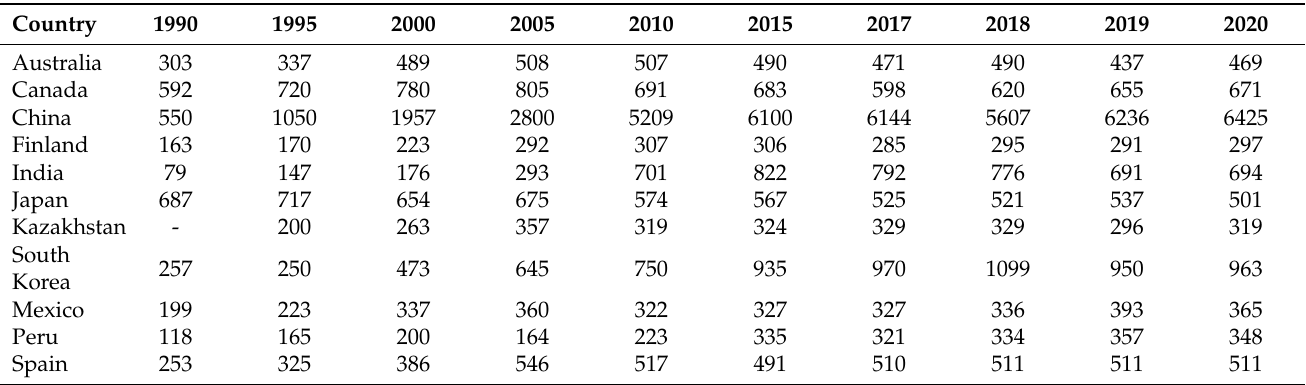
Table 4. Refined zinc production by country, thousands of tones, worked out based on data from [19,29–32].